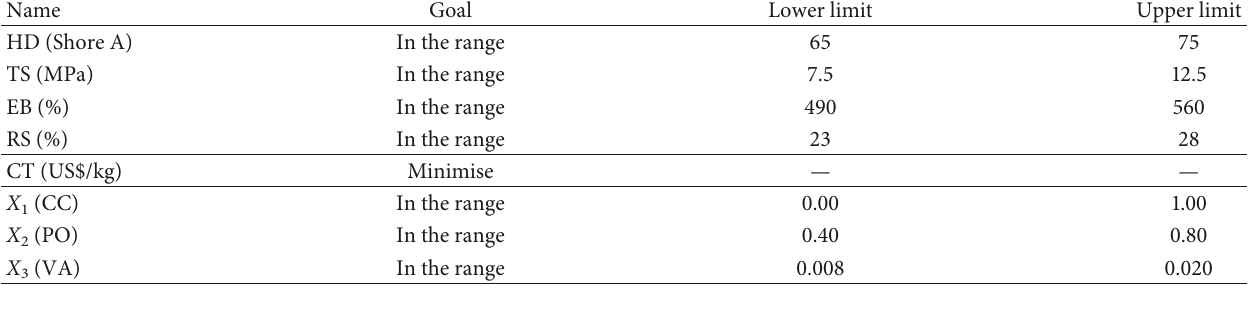
Table 7: Constraint requirements posed on mechanical properties (HD, TS, EB, and RS) and raw materials’ (CC, PO, and VA) weight fraction ranges that minimise costs of the composites, as returned by the PSO algorithm.